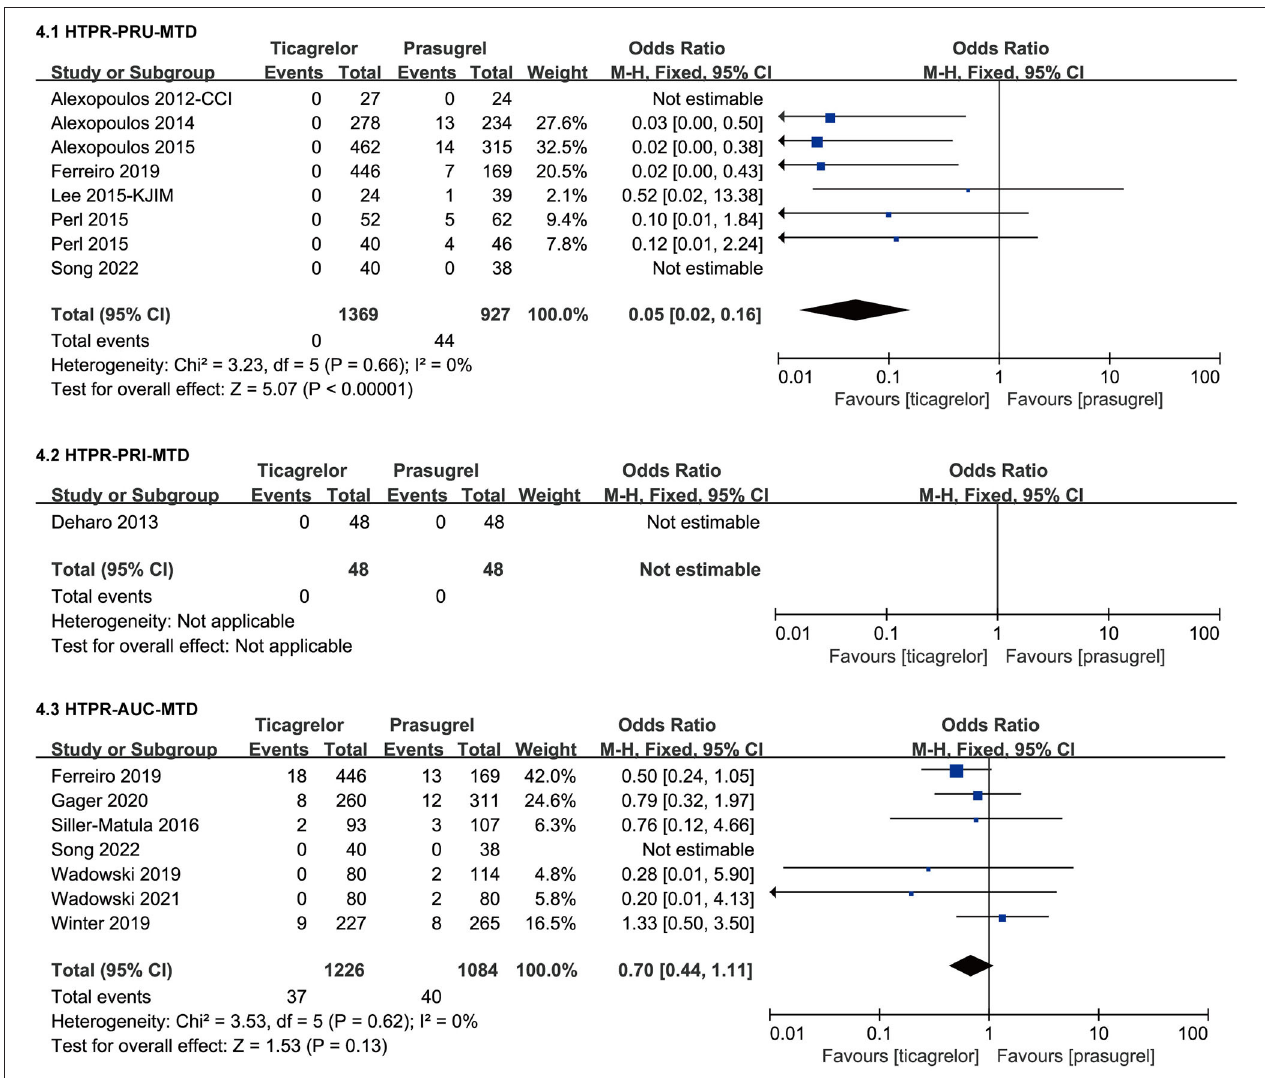
FIGURE 7 | Forest plots of meta-analysis results of HTPR after